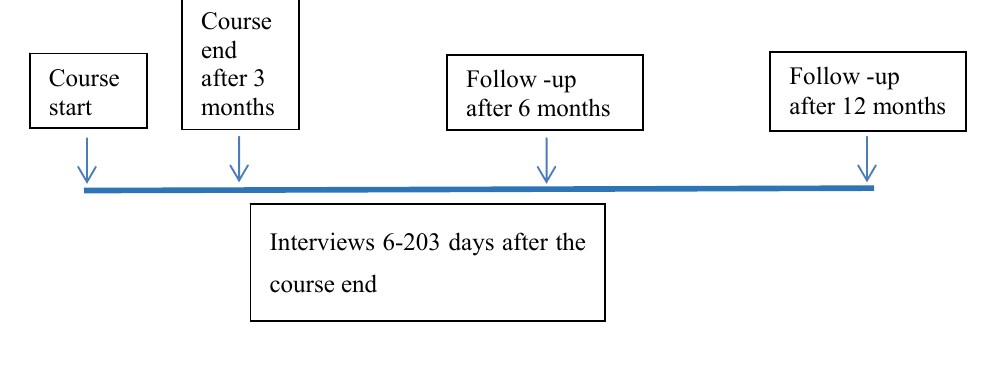
Figure 5. Timeline illustrating the four measuring points: start of course as the baseline measure, the first follow-up at end of course 12 weeks after the course start, and follow-up 6 months and 12 months after end of course and timeframe variation for the